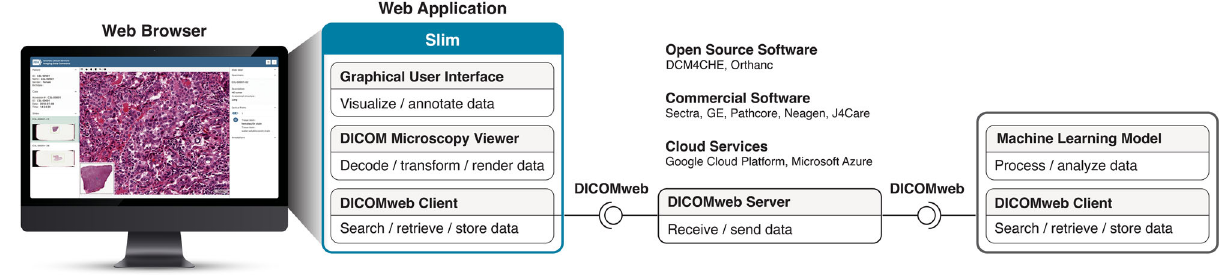
Fig. 1 | Components of the Slim web application and communication of data using DICOMweb services. Component diagram showing relevant client and ser- vercomponentsandtheirinterfaces.Slimisasingle-pageapplicationthatrunsfully client side in a web browser without any custom server side components. All data communicationoccursviastandardDICOMwebservices.Theapplicationexposesa